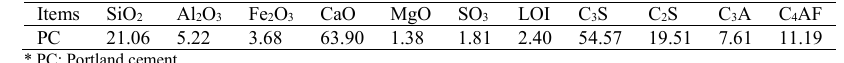
Table 1: Chemical compositions of cement (wt. %).